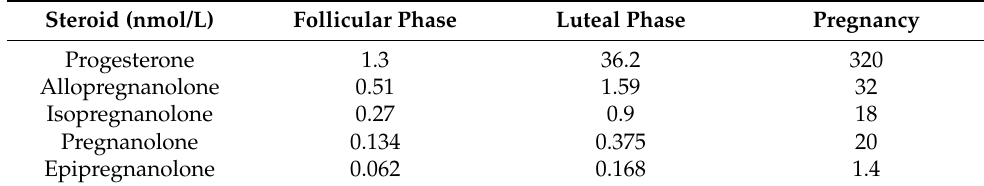
Table 2. Physiological levels of progesterone and its neuroactive metabolites in fertile women in the follicular and luteal phase of the menstruation cycle and in pregnancy; medians of serum levels are shown. Data were determined using the gas chromatography-tandem mass spectrometry method by Hill et al. [99]. Steroid (nmol/L) Follicular Phase Luteal Phase Pregnancy Progesterone 1.3 36.2 320 Allopregnanolone 0.51 1.59 32 Isopregnanolone 0.27 0.9 18 Pregnanolone 0.134 0.375 20 Epipregnanolone 0.062 0.168